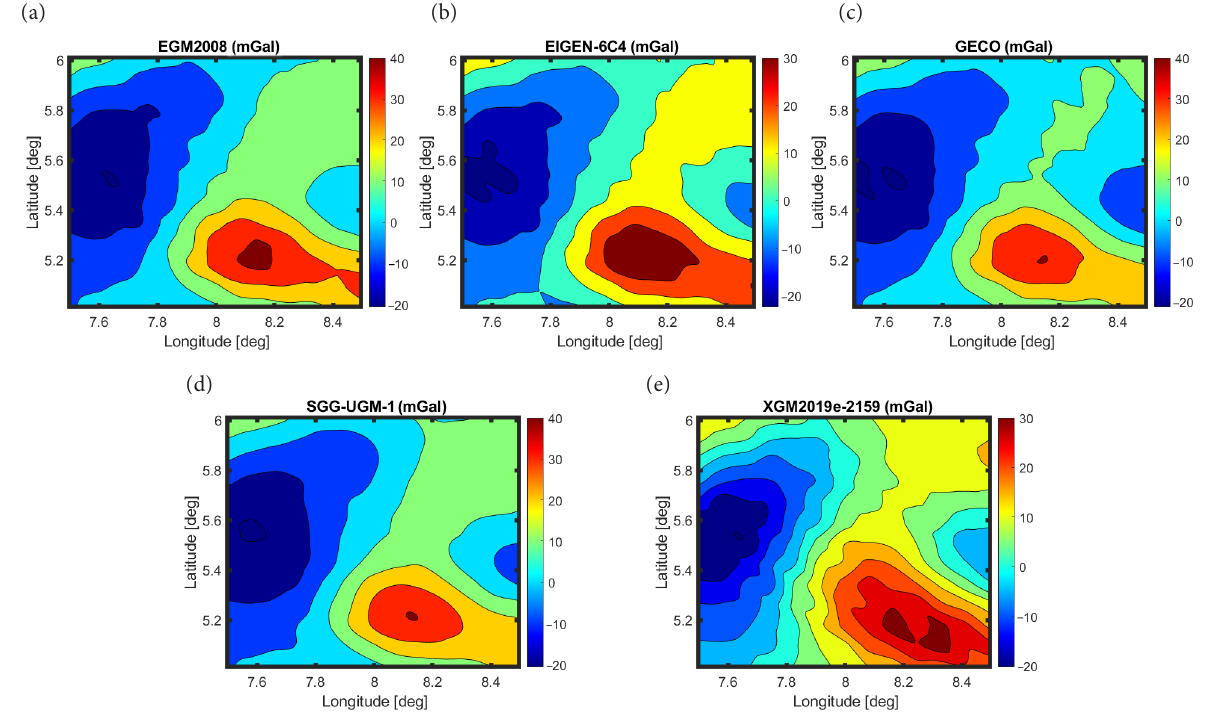
Figure 8. GGM-derived Bouguer gravity map of the Afikpo